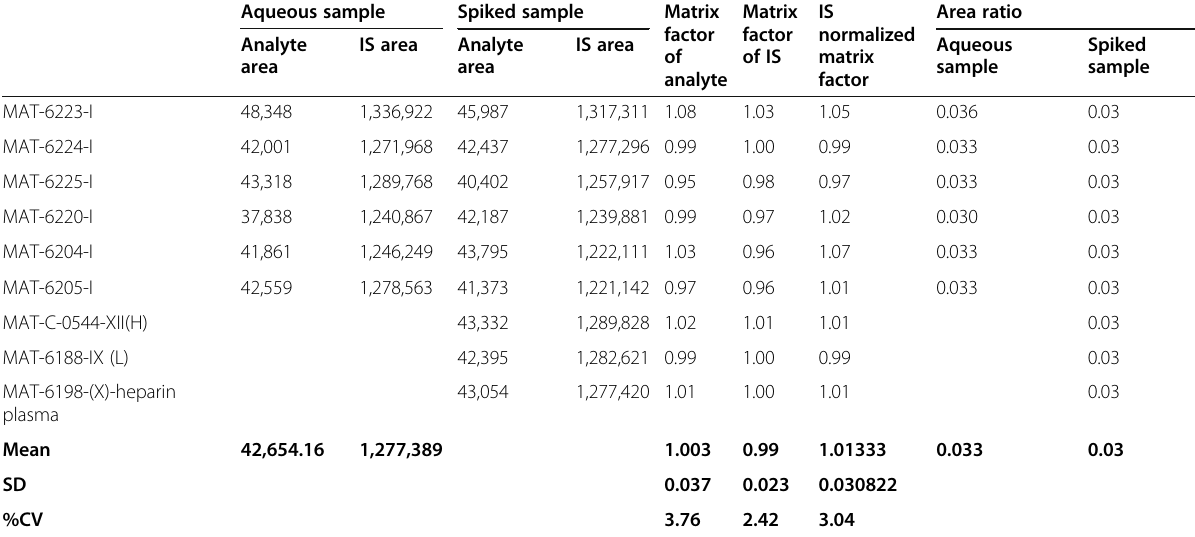
Table 4 Matrix effect and matrix factor for bexarotene at LQC level